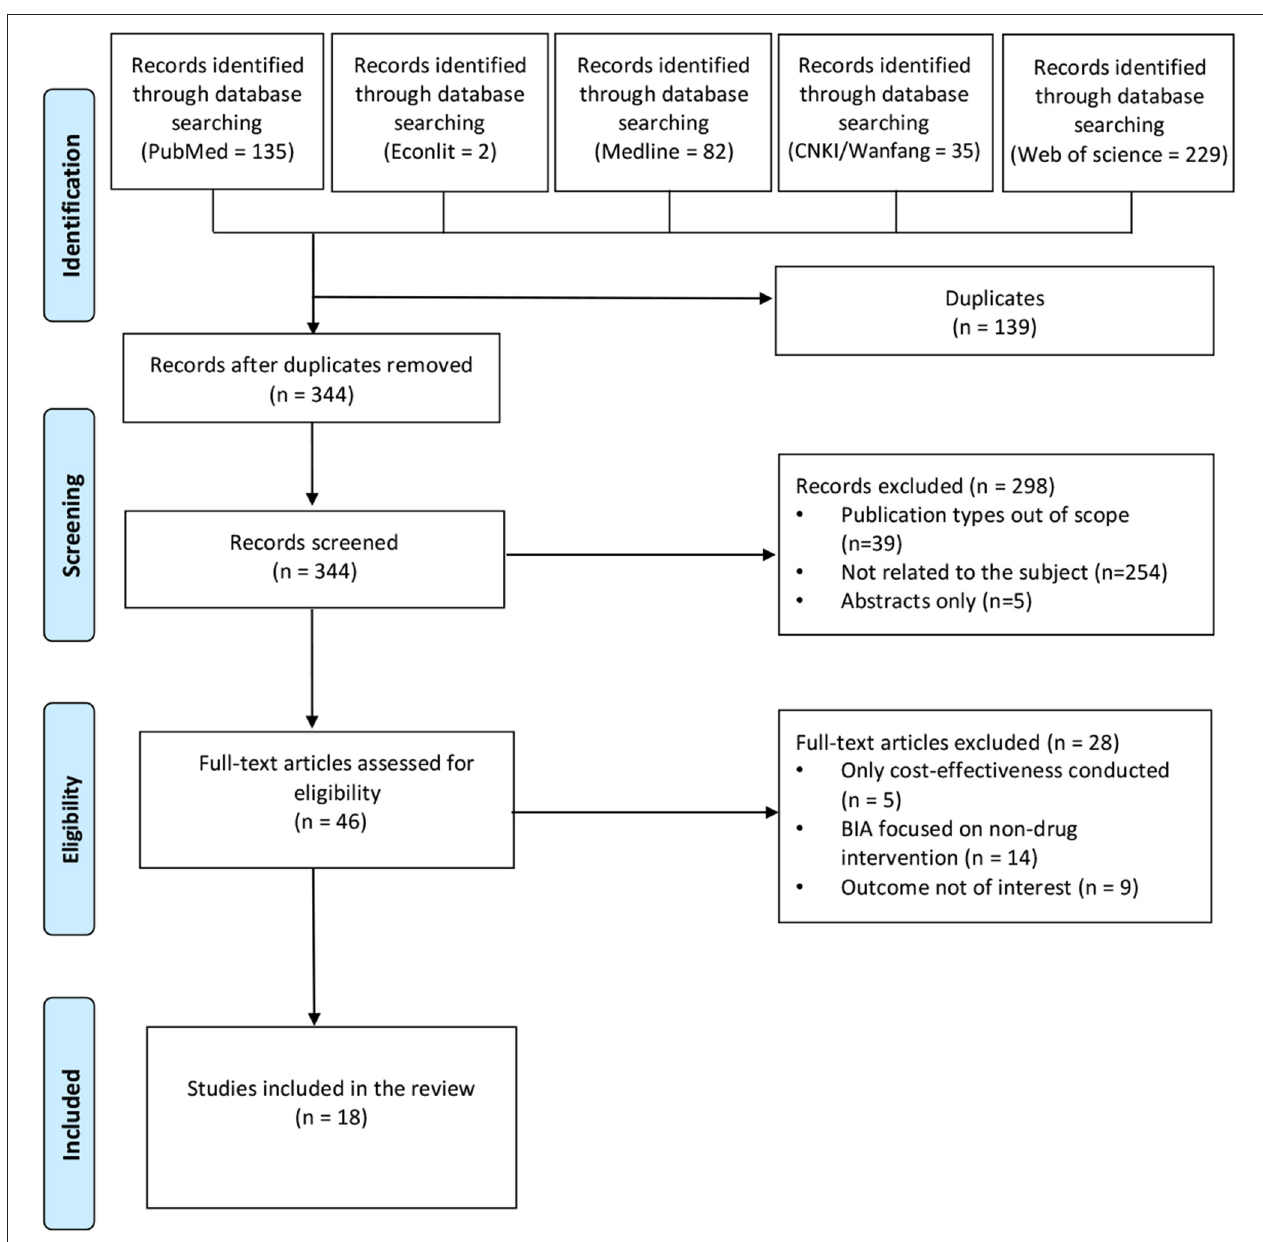
FIGURE 1 | PRISMA flowchart of literature search and selection of